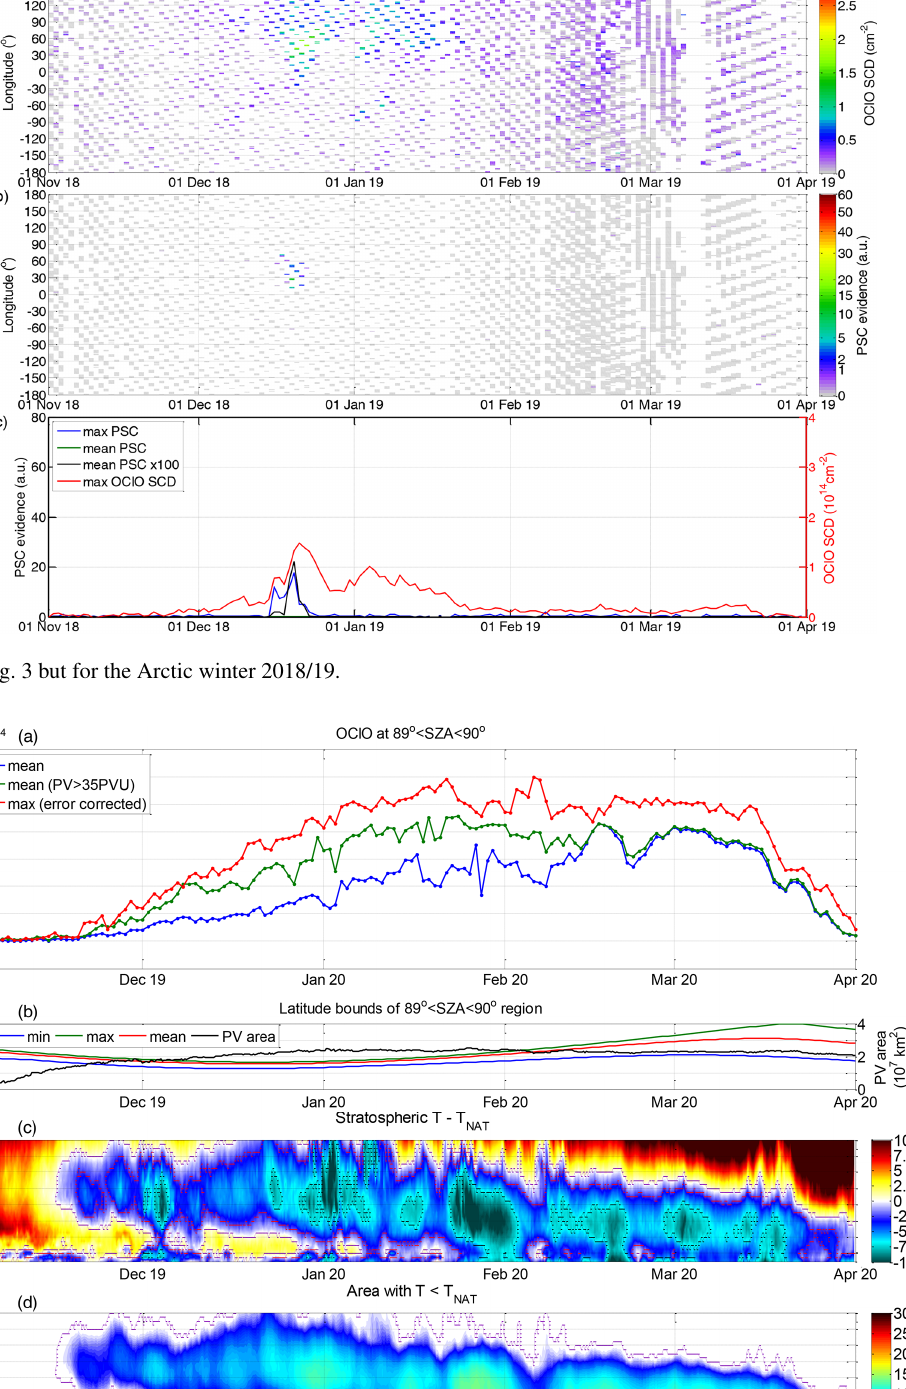
https://doi.org/10.5194/acp-22-245-2022 Atmos. Chem. Phys., 22, 245–272,